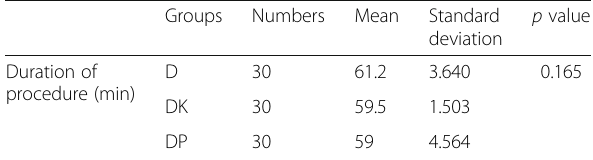
Table 5 Duration of the